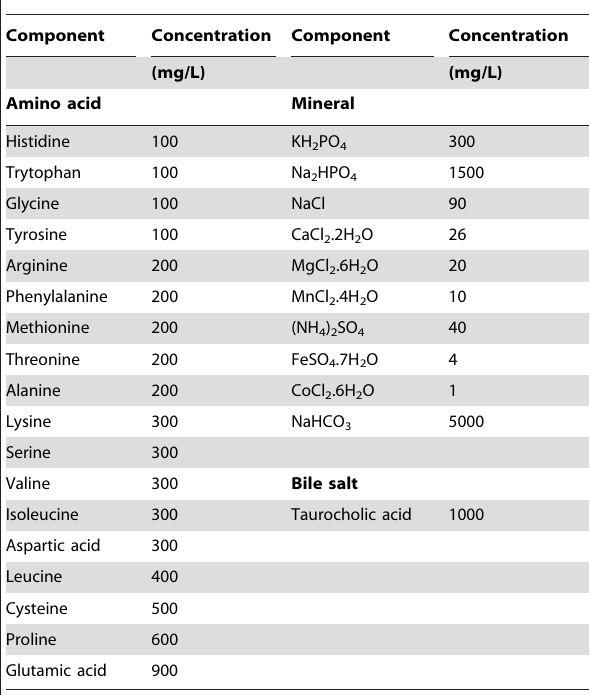
Table 1. Formulation of Clostridium difficile spore germination solution consisting of amino acids, minerals and taurocholic acid prepared in sterile deionized